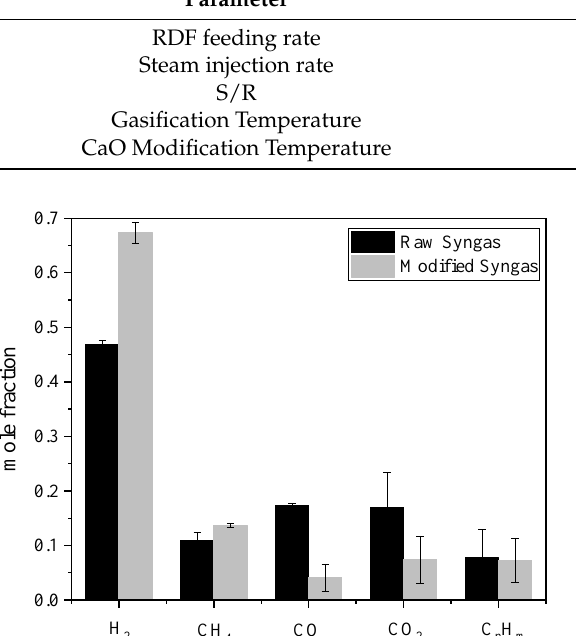
Figure 5. Gas components before and after CaO modification. It can be seen from Figure 5 that H 2 has the highest concentration in the two syngas streams. For the raw syngas, H 2 approximately accounts for 46.9% of the total volume, while, after modification by CaO, the concentration reached 67.3%. By introducing steam into the gasifier, the equilibrium of reactions from (5)–(7) shifted towards the product side, enhancing H 2 production. After modification by CaO particles, the H 2 fraction significantly increased with a significant drop in the CO and CO 2 concentration. The CO 2 content in the syngas was absorbed by the CaO particles in the modification reactor, enhancing H 2 production by shifting the water gas shift reaction (6) towards the product side. LHV of the syngas was also increased after the raw syngas flow through the CaO bed, as shown in Figure 6. The increase in the H 2 and CH 4 mole fraction contributes to the increase in the syngas LHV. The CGE for the raw syngas and modified syngas are 0.687 and 0.656, respectively.